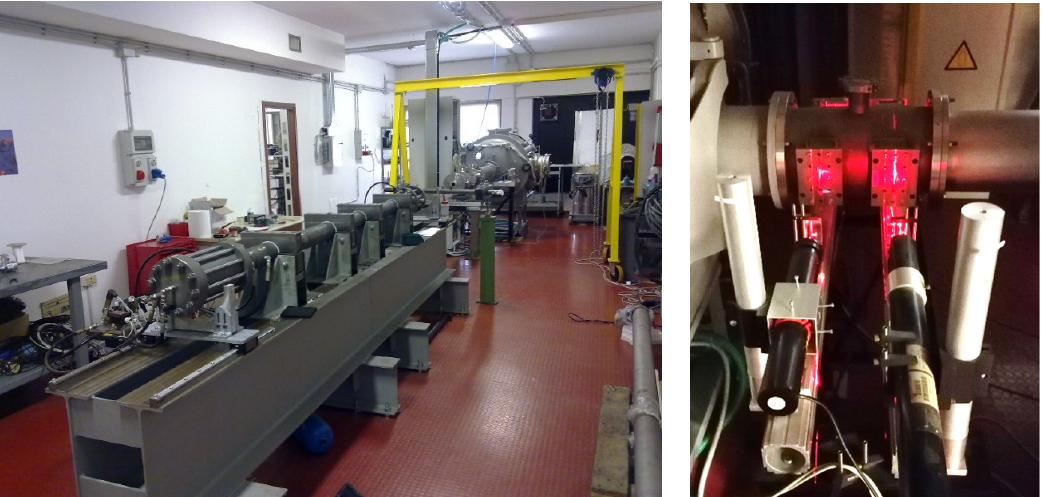
Figure 1. CISAS Hypervelocity Impact Facility with the LGG ( left ) and laser system for projectile velocity measurement ( right ).